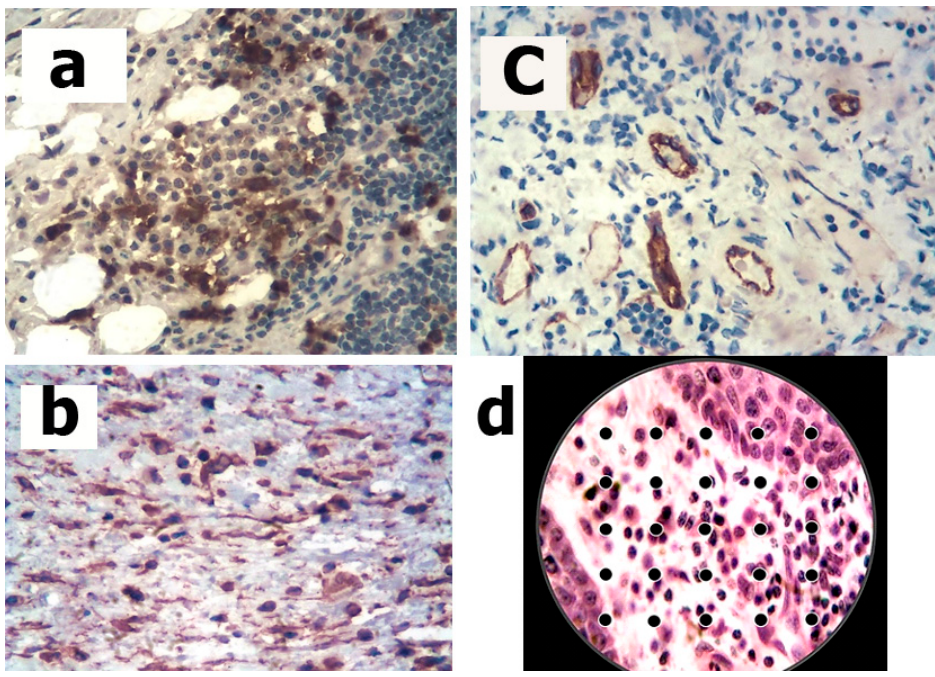
Figure 2. Examples of immunohistochemical identification of neutrophils, fibroblasts, and endotheliocytes, as well as a 25-point morphometric grid for counting cells in the preparation. ( a ) Accumulation of neutrophilic leukocytes in the cell infiltrate. Reaction with MABs against myeloperoxidase. LSAB method with additional staining with hematoxylin: ×400. ( b ) Fibroblasts in cellular infiltrate. Reaction with MABs against vimentin. LSAB method with additional staining with hematoxylin: ×400. ( c ) Clusters of endotheliocytes and small vessels of the capillary type. Reaction with MAb against CD 31. LSAB method with additional staining with hematoxylin: ×400. ( d ) Morphometric reticle of G.G. Avtandilov when counting cellular composition. Stained with hematoxylin and eosin: ×800.